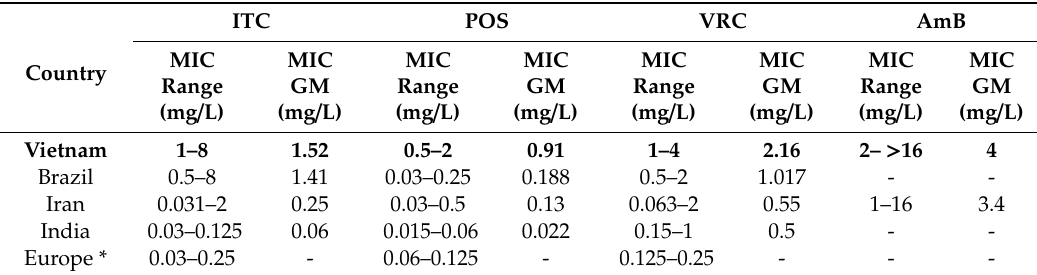
Table 3. MIC ranges and geometric mean for A. flavus sensu stricto isolates from the Mekong Delta Region of Vietnam, compared to published MICs for environmental isolates from Brazil ( n =